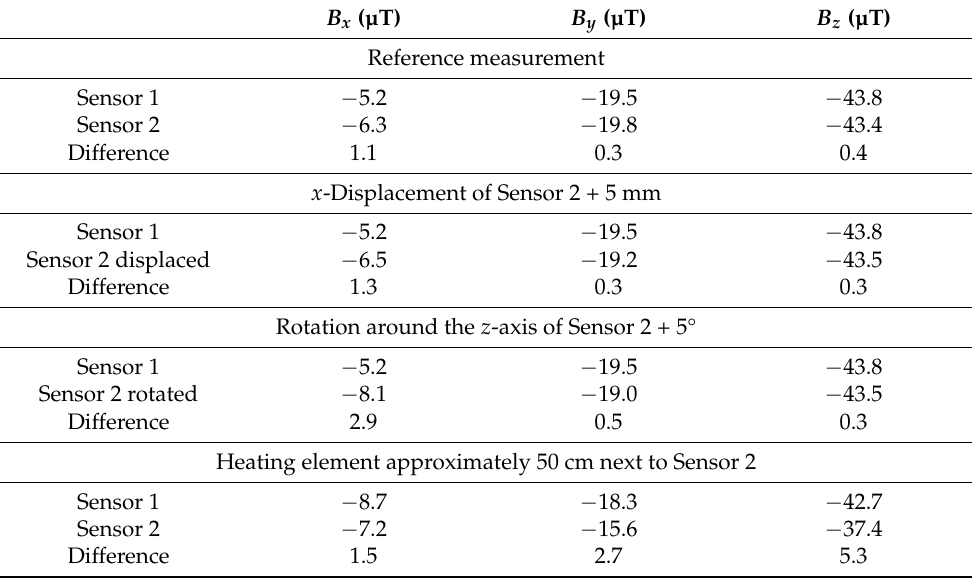
Table 1. Comparison of the three measured values at the two LSM303D. The absolute difference between the corresponding measured components is